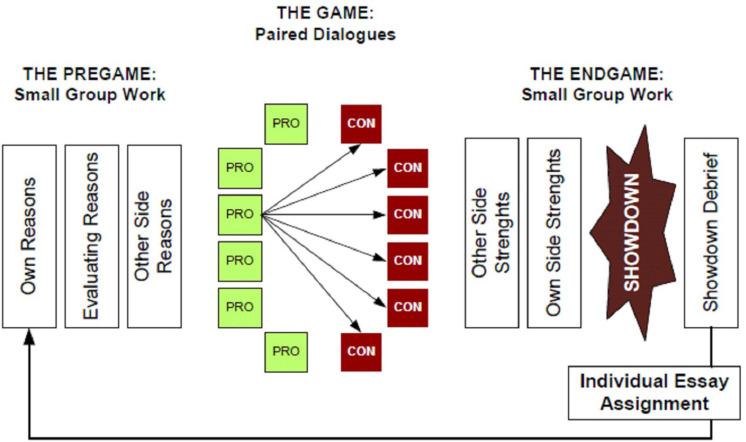
The AWM structure.